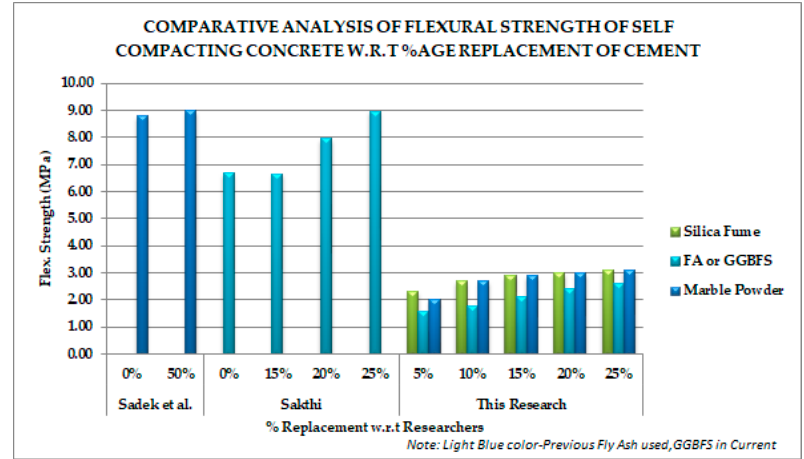
Figure 5. Comparative flexural strength trend with respect to cement replacement of previous studies (Sadek [9] and Sakthi [42]).